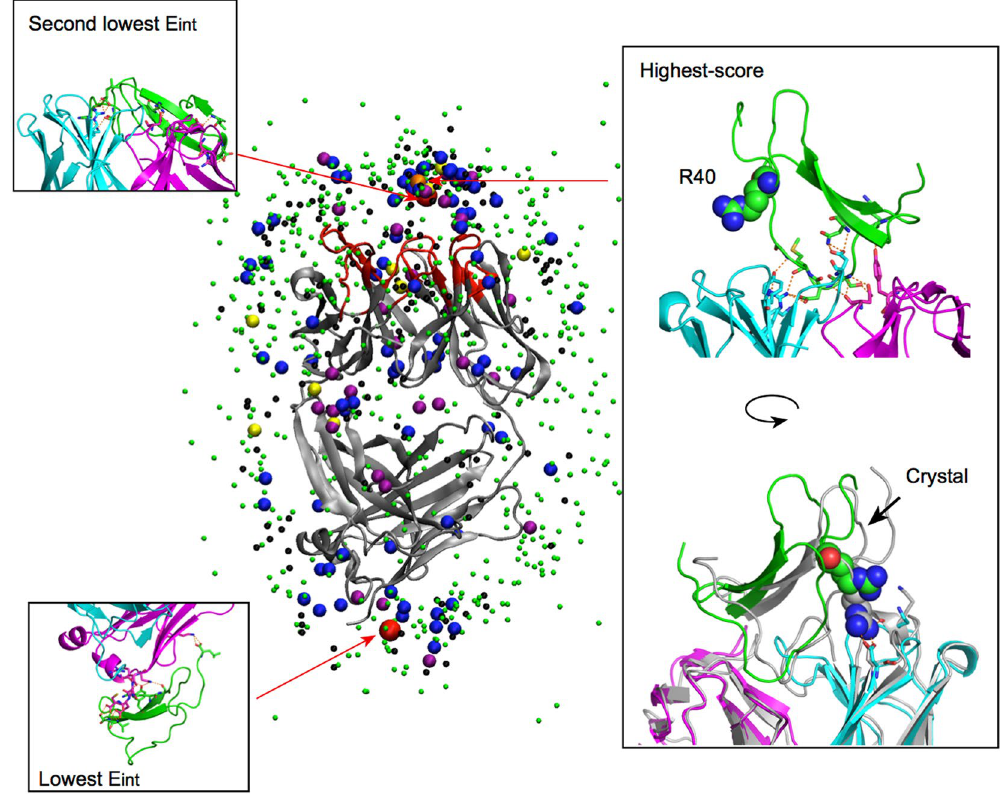
Figure 1. Positions of the EPR COMs on 9E5 observed by binding simulations at 200 ns. The COMs for EPR were classified by the interaction energy (Eint) between EPR and 9E5, and are represented by different colours and circle sizes. Red large circles represent the EPR positions for which Eint was − 877 kJ/mol (bottom position) and − 810 kJ/mol (approximately the CDR position). Yellow circles, purple circles, blue circles, small black circles, and small green circles represent the positions with the following interaction energies; − 800 kJ/mol < Eint ≤ − 700 kJ/mol, − 700 kJ/mol < Eint ≤ − 600 kJ/mol, − 600 kJ/mol < Eint ≤ − 500 kJ/mol, − 500 kJ/ mol < Eint ≤ − 400 kJ/mol, and − 400 kJ/mol < Eint, respectively. The COM of the highest-score structure is represented as an orange circle. 9E5 is represented as a cartoon in grey. CDRs are indicated in red. The EPR- bound structures with the lowest and second lowest Eint, as well as the highest-score structure, are shown as indicated (see inset). The heavy chain, light chain, and EPR in the bound structures are coloured cyan, magenta, and green, respectively. In the figure of the highest-score structure, the crystal structure is also shown in grey (right inset). Interacting residues and hydrogen bonds between EPR and 9E5 are indicated using a stick representation and dashed orange lines,